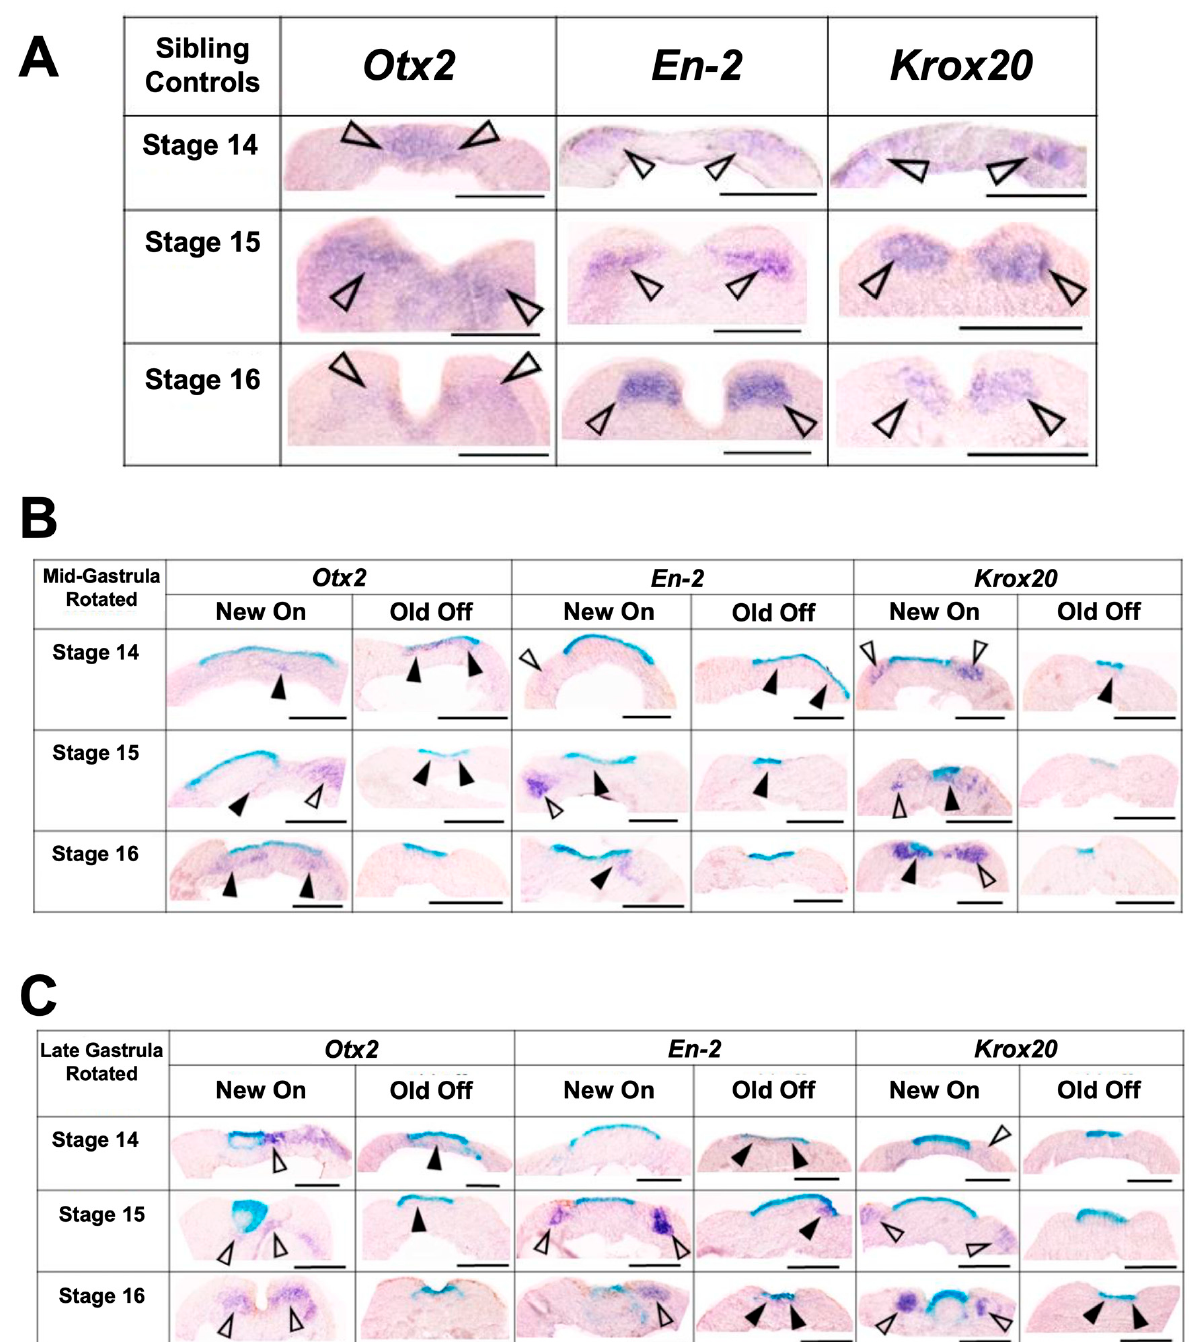
Figure 12. Representative histology images for sibling control embryos ( A ), mid-gastrula rotated transplants ( B ), and late gastrula rotated transplants ( C ) at stages 14–16. Dorsal is facing up. Purple stain marked with a solid arrowhead indicates gene expression colocalized with transplant tissue, purple stain marked with an empty arrowhead indicates endogenous gene expression, and blue stain indicates transplant incorporation. As embryos develop from stage 14–16, sections showed progressive activation of correct marker gene expression and repression of ectopic marker gene expression. Scale bar represents 250 μ m.